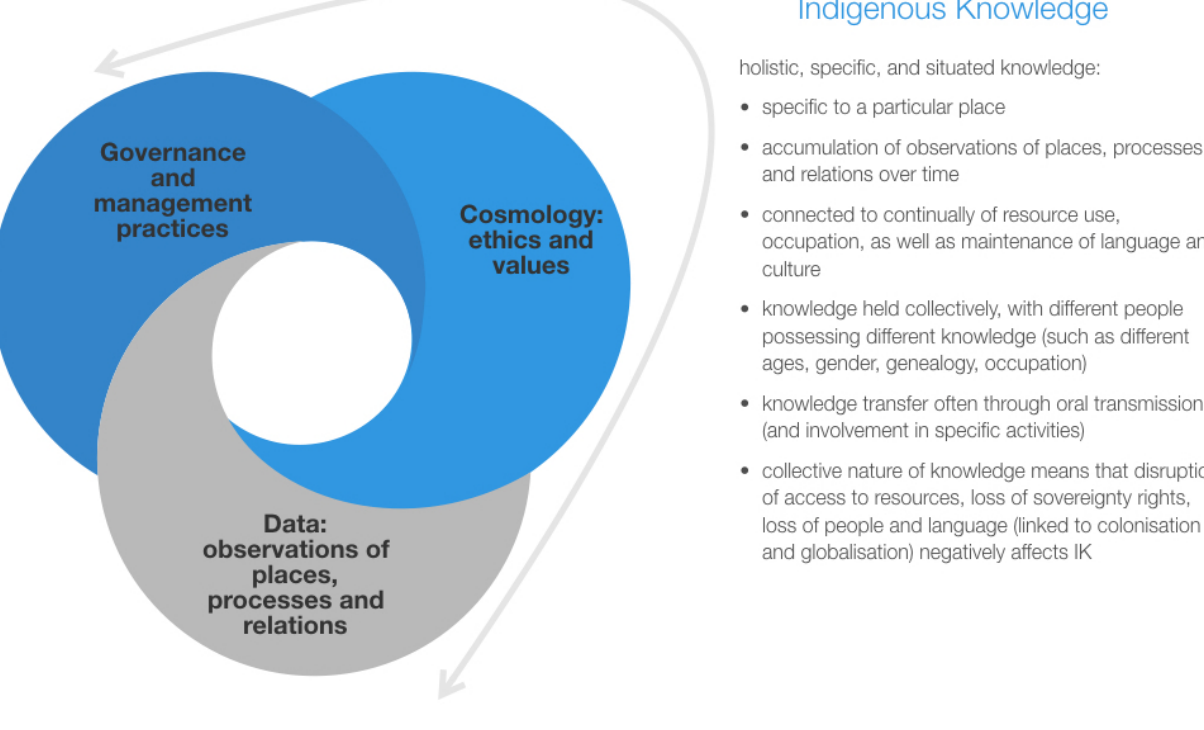
Figure 1. The different dimensions of Indigenous Knowledge and its